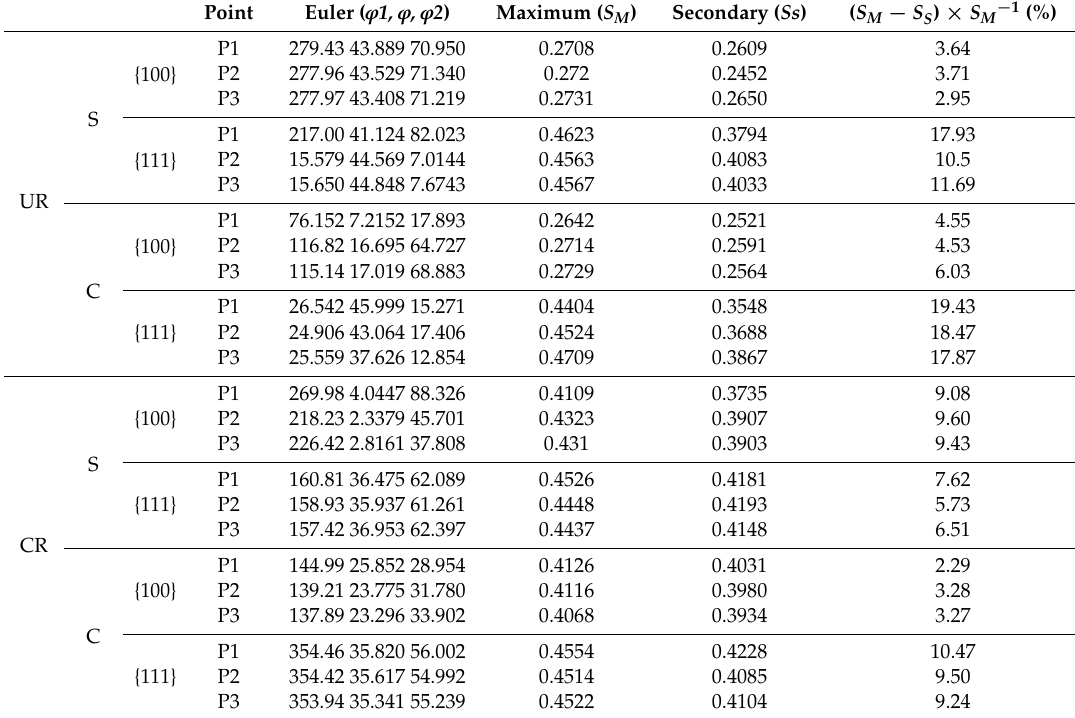
Table 3. Schmid factor difference ratio (SFDR) of some points as well as relative parameters used for the SFDR